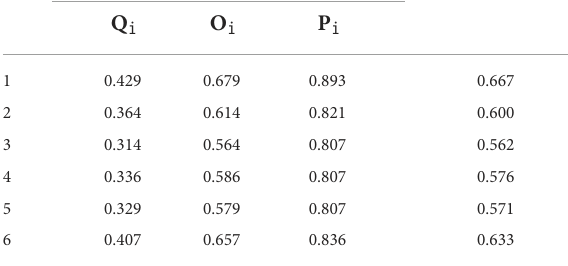
TABLE 8 Defuzzification of D ratings in